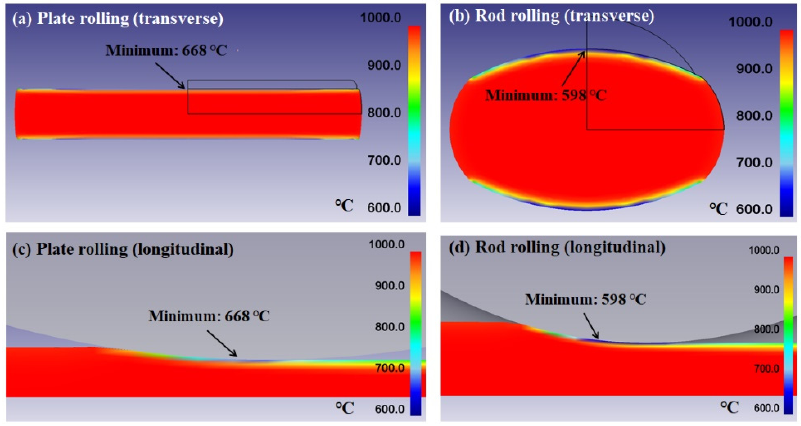
Figure 8. Comparison of contour maps of temperature in the roll bite during plate rolling and rod rolling.